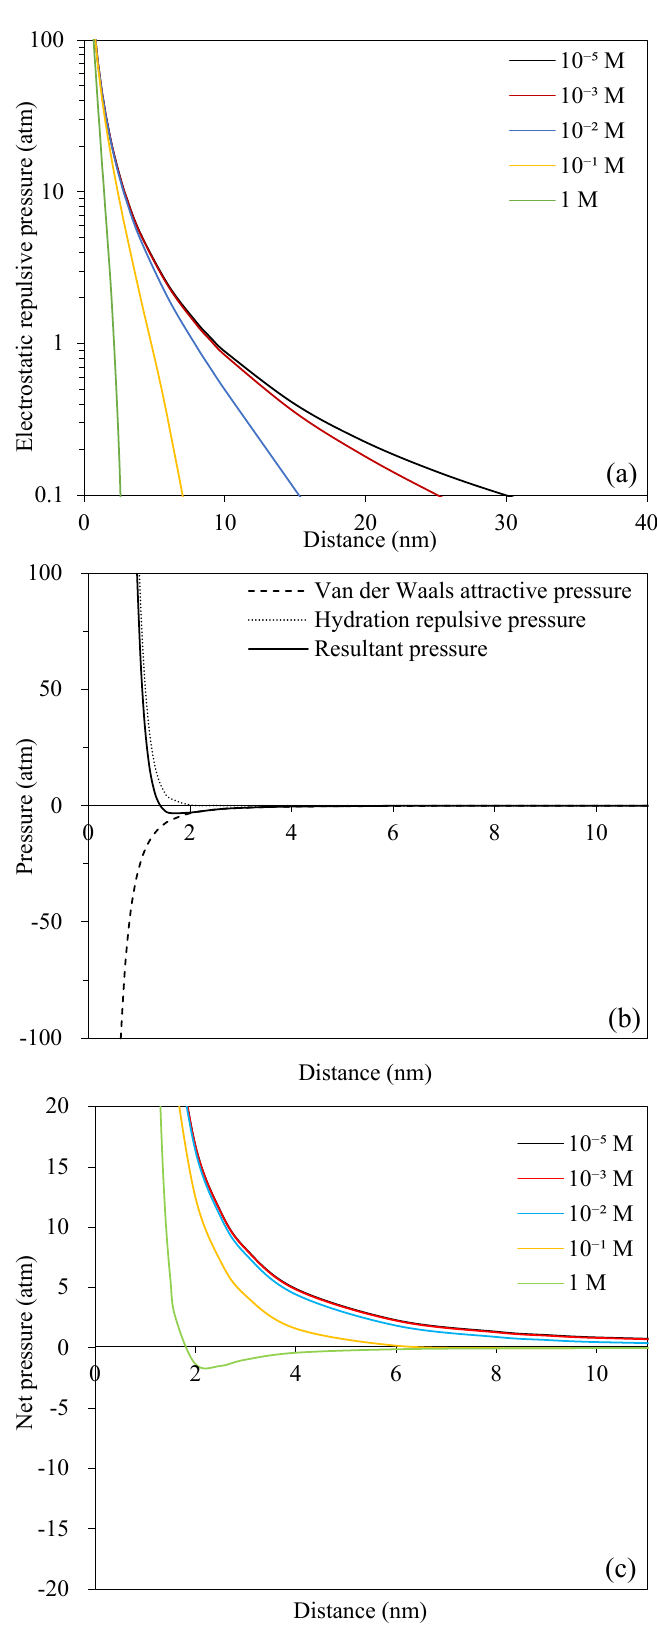
Figure 3. Distributions of electrostatic repulsive pressure( a ); hydration repulsive pressure, van der Waals attractive pressure, and its resultant pressure ( b ); net interaction pressure ( c